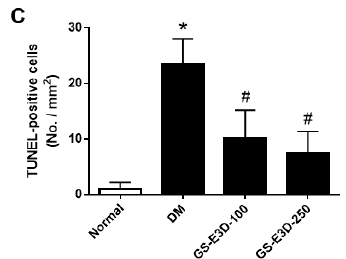
Figure 4. Effects of GS-E3D on histopathological alteration and apoptosis in renal tissues of db/db mice. ( A ) Histological analysis of renal tissues and images of hematoxylin and eosin (HE) staining. ( B ) TUNEL staining. Arrows indicate TUNEL-positive cells. ( C ) TUNEL+ cells counted from fluorescence microscopic images. Scale bar equals 50 µ m. Data are presented as the mean ± standard deviation (n = 8). * p < 0.05 vs. Normal group; # p < 0.05 vs. DM group.